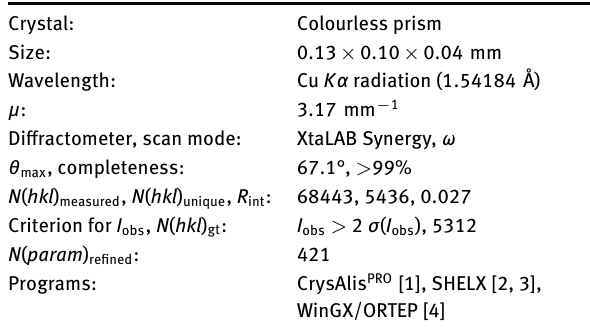
Table 1: Data collection and